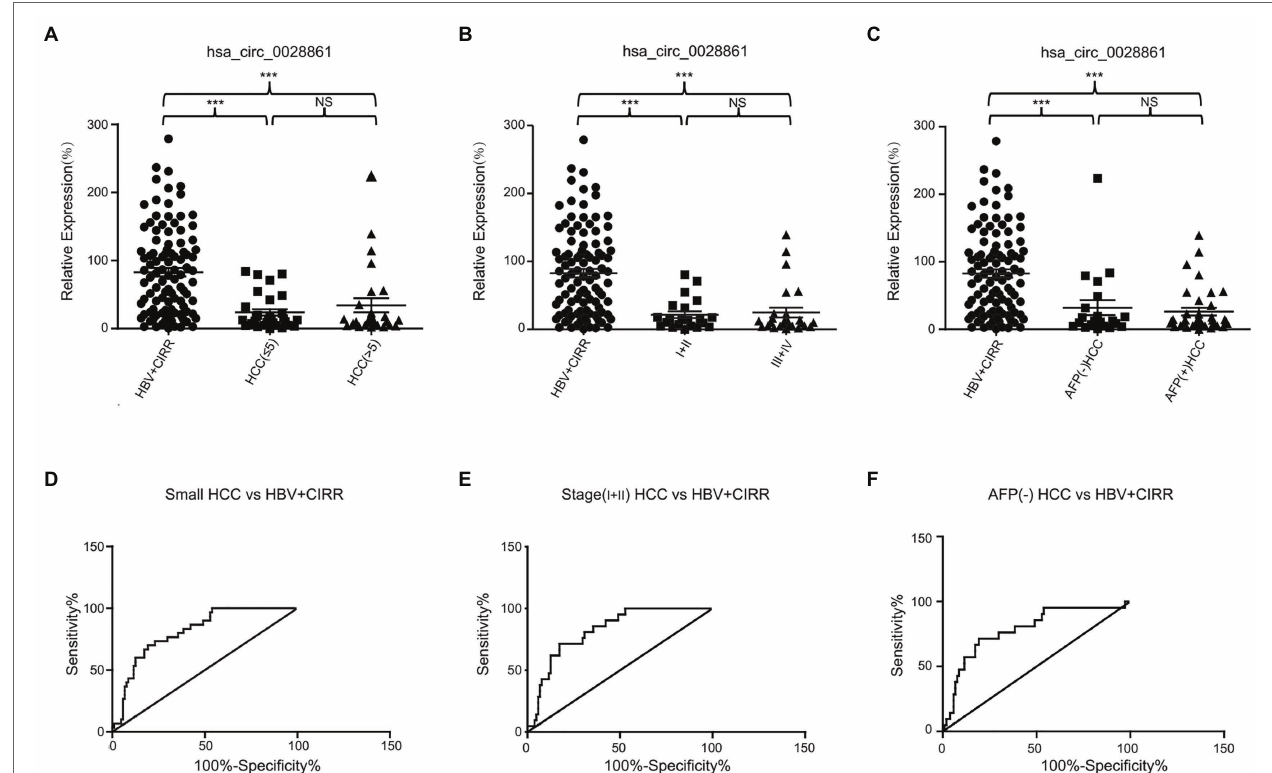
FIGURE 4 | The role of hsa_circ_0028861 in the diagnosis of small, early-stage, and AFP ( − ) HCC patients. (A) The expression profile of serum exosomal hsa_circ_0028861 in small (size ≤ 5) and large (size > 5) tumors compared with chronic HBV and cirrhosis individuals. (B) The expression profile of serum exosomal hsa_circ_0028861 in early-stage (stage I-II) and late-stage (size III-IV) tumors compared with chronic HBV and cirrhosis individuals. (C) The expression profile of serum exosomal hsa_circ_0028861 in AFP ( − ) and AFP (+) tumors compared with chronic HBV and cirrhosis individuals. (D–F) The ROC curves of